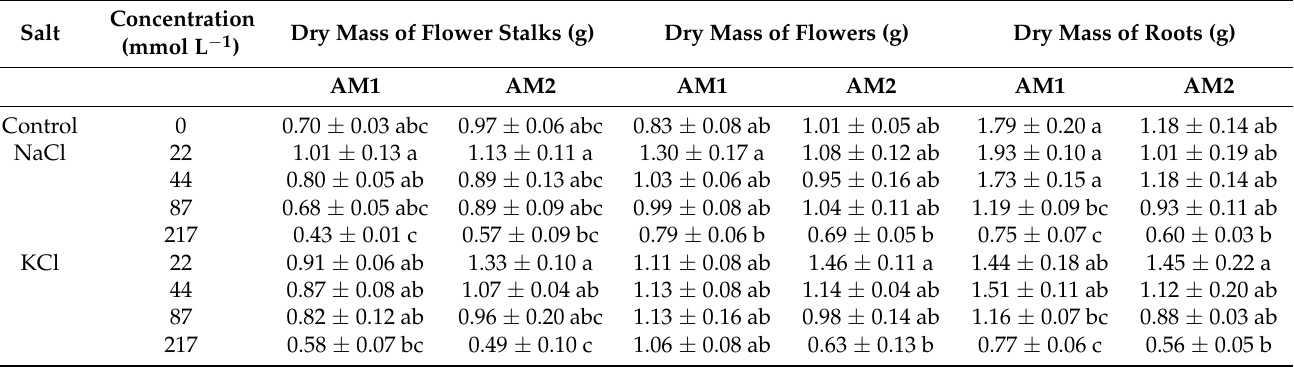
Table 3. Effect of salinity treatment on dry mass of generative parts and roots of Armeria maritima accessions AM1 and AM2 cultivated for 8 weeks in